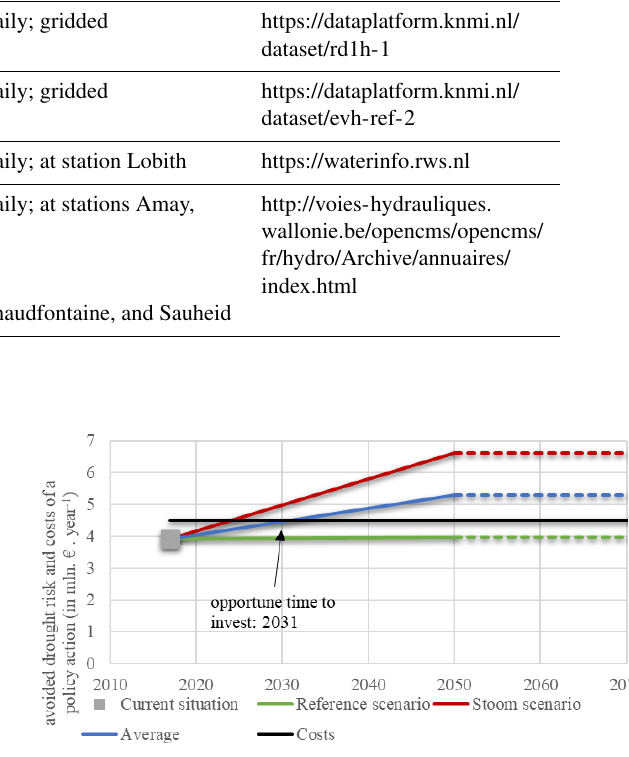
Figure 3. Determination of opportune time to invest based on the time when the average avoided drought risk of the reference and Stoom scenarios intersects with the annual costs (EAA). Note that extrapolation beyond 2050 is required for societal cost–benefit anal- yses of public investments in the Netherlands and is limited to 100 years ahead in the